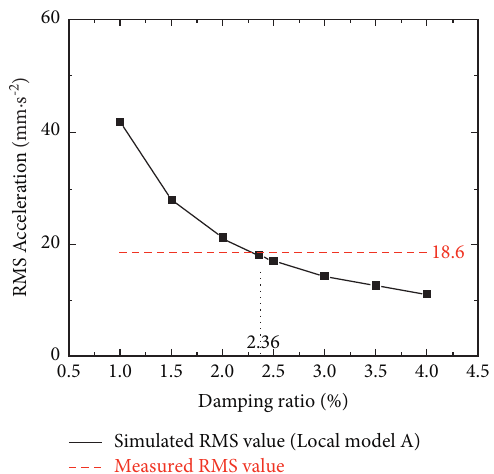
Figure 15: The effect of structural damping ratio on the vertical maximum RMS acceleration of the